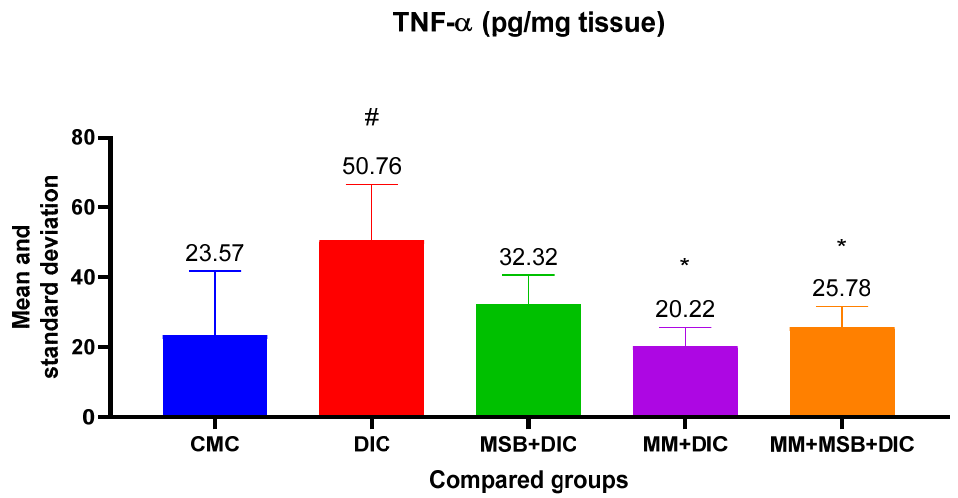
Figure 4. Mean value and standard deviation of TNF- α between analyzed groups. Group I-CMC, negative control group; group II-DIC, disease control group; group III-MSB+DIC, group receiving MegaSporeBiotic; group IV-MM+DIC, group receiving MegaMucosa; group V-MM+MSB+DIC, group receiving MegaSporeBiotic and MegaMucosa; *, p < 0.05 compared with group II (DIC); #, p < 0.05 compared with group I (CMC).